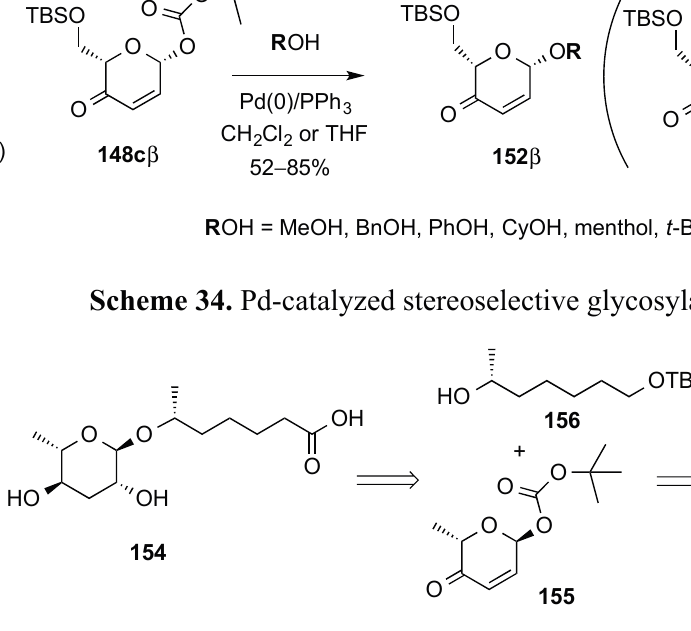
Scheme 35. O’Doherty’s approach to daumone, 154 .